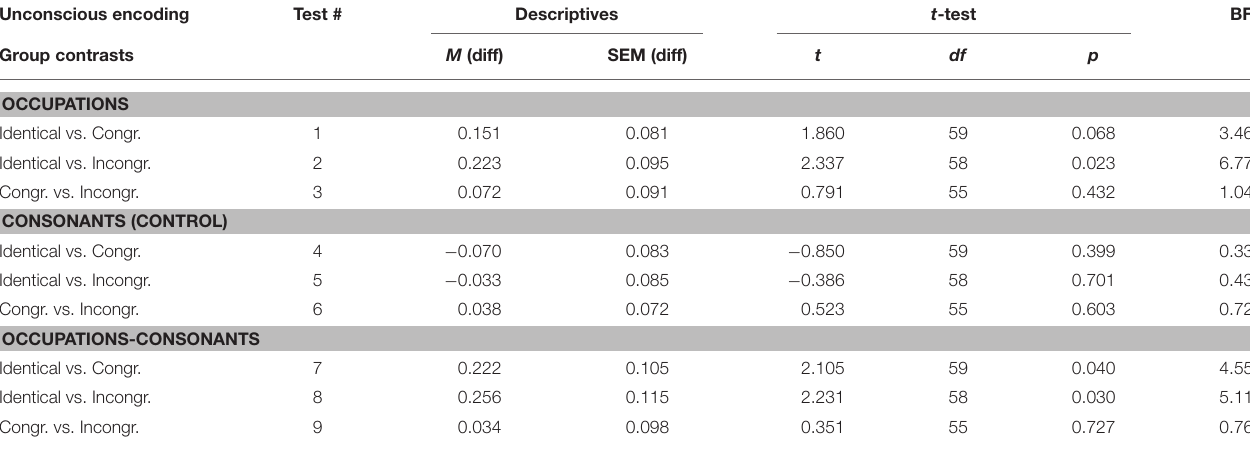
TABLE 3 | Difference in decision bias between congruency groups. Unconscious encoding Test # Descriptives t